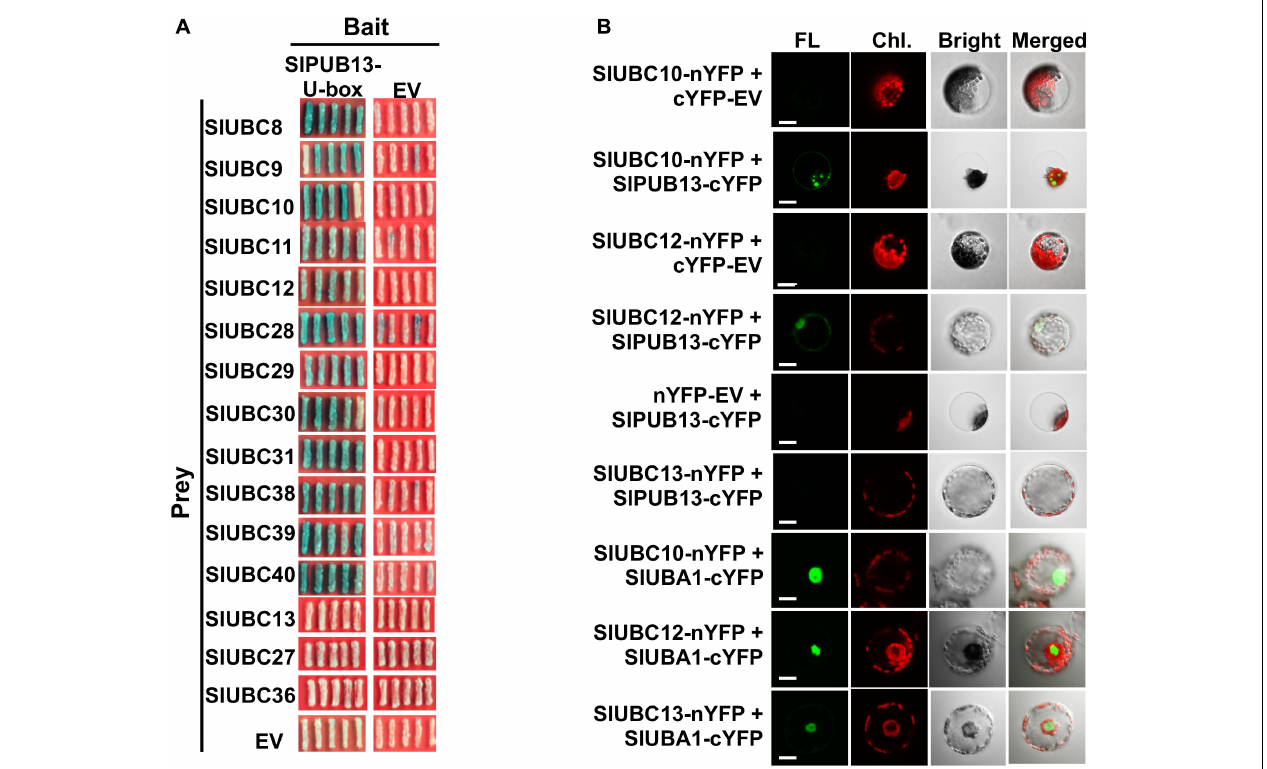
FIGURE 3 | Group III E2s interact with tomato SlPUB13 in vivo . (A) Members of the group III E2s interact with the U-box domain of tomato SlPUB13 in yeast two-hybrid. Empty vectors and non-group III E2s were used as the negative control. (B) SlUBC10 and SlUBC12 of group III E2s interact with SlPUB13 in the BiFC assay. Non-group III E2 SlUBC13 was used as negative control. Different construct pairs were transiently co-expressed in protoplasts isolated from N. benthamiana leaves. Cells were examined with a confocal microscope under bright or laser light to detect cells and green fluorescence, respectively. The empty vector expressing N- and C-terminus of YFP (nYFP-EV and cYFP-EV) were used as negative control. EV, empty vector; FL, fluorescence; Chl., chlorophyll autofluorescence; Bright, bright field image. Scale bar = 20 µ m.